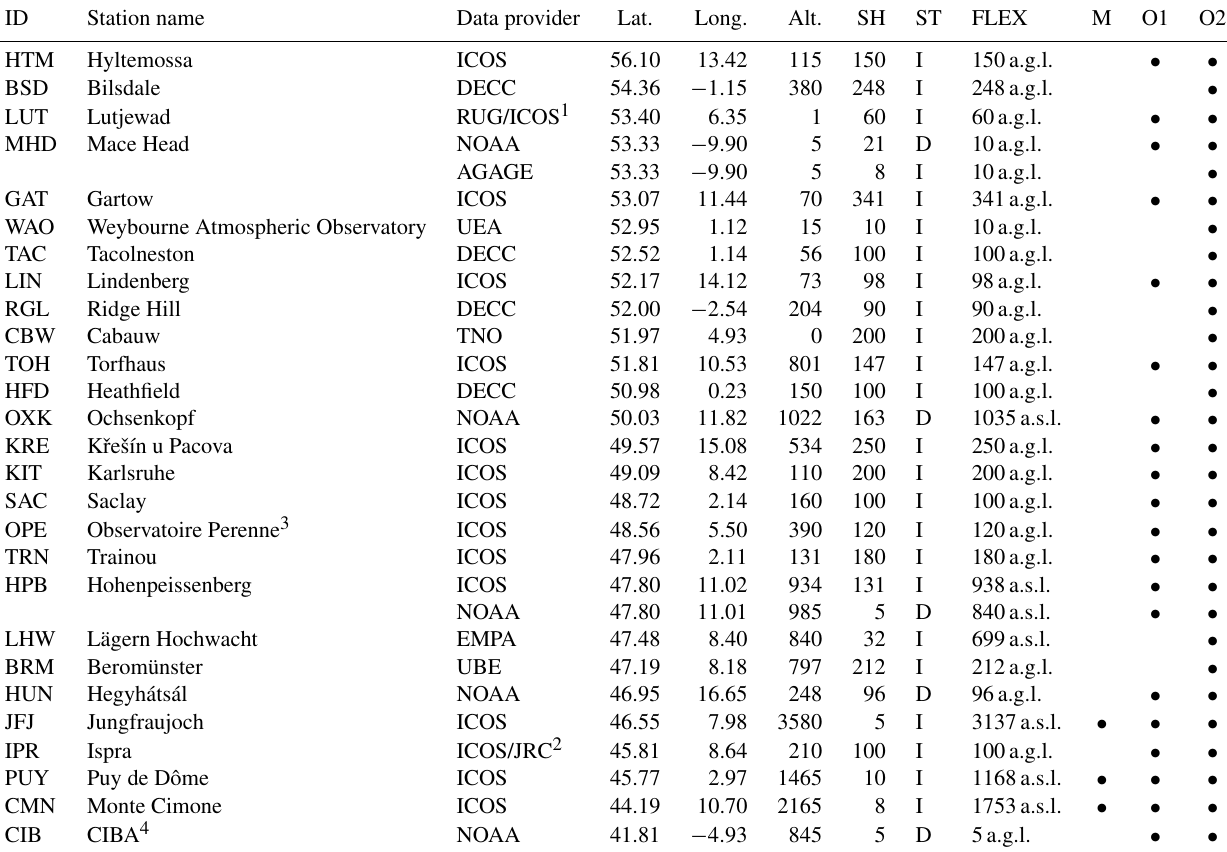
Table 1. European monitoring stations used in this study. “Alt” is the surface altitude (m above sea level), “SH” is the sampling height (m) above ground, “ST” specifies the sampling type (“I”: in situ measurements; “D”: discrete air sample measurements). “FLEX” is the release height (m) used for calculation of the FLEXPART-COSMO back trajectories (“a.g.l.”: release height above model surface; “a.s.l.”: release height above sea level). The column “M” indicates the stations which have been classified as mountain stations. The last two columns indicate the use of the corresponding station data in the observation data sets O1 and